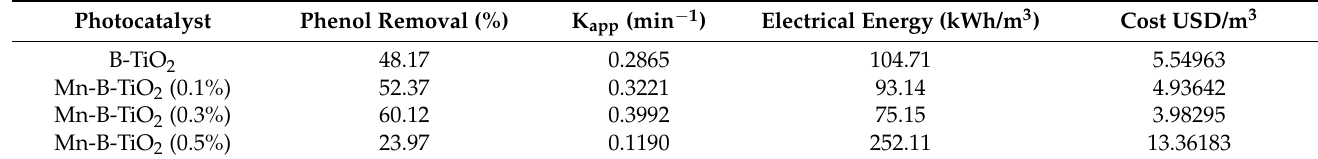
Table 3. Apparent rate constants, and electrical energy consumption by different